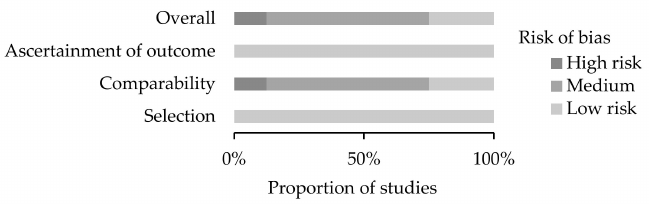
Figure 1. Quality assessment using the Newcastle–Ottawa Scale of studies included in the present systematic review ( n = 8).